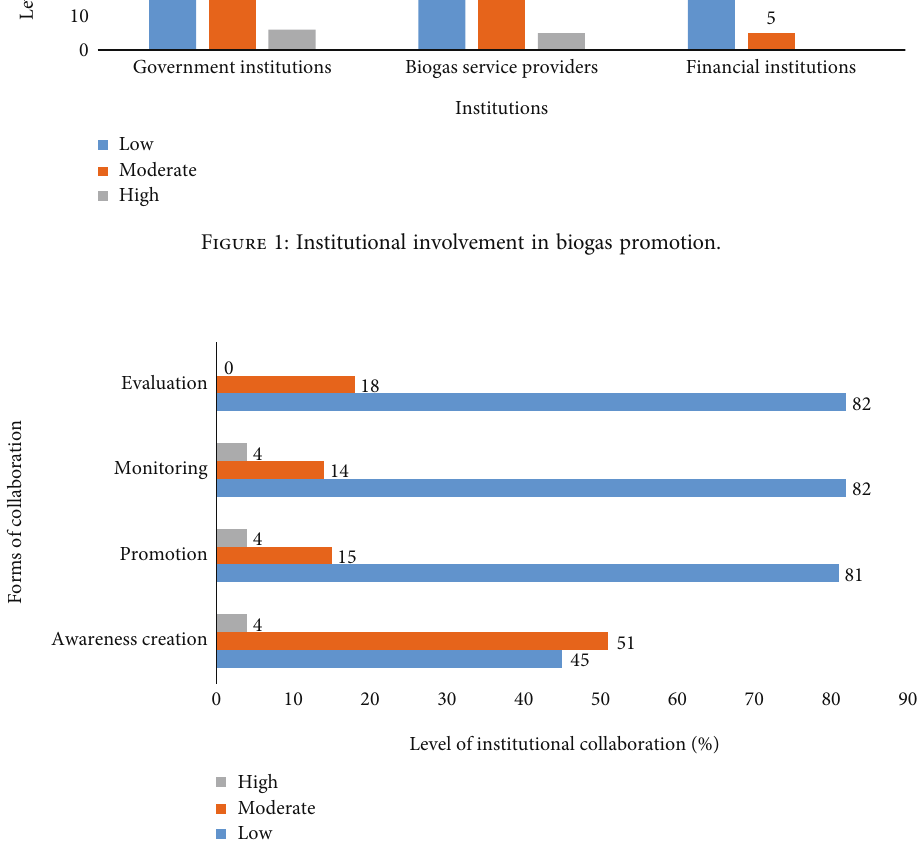
Figure 2: Level of